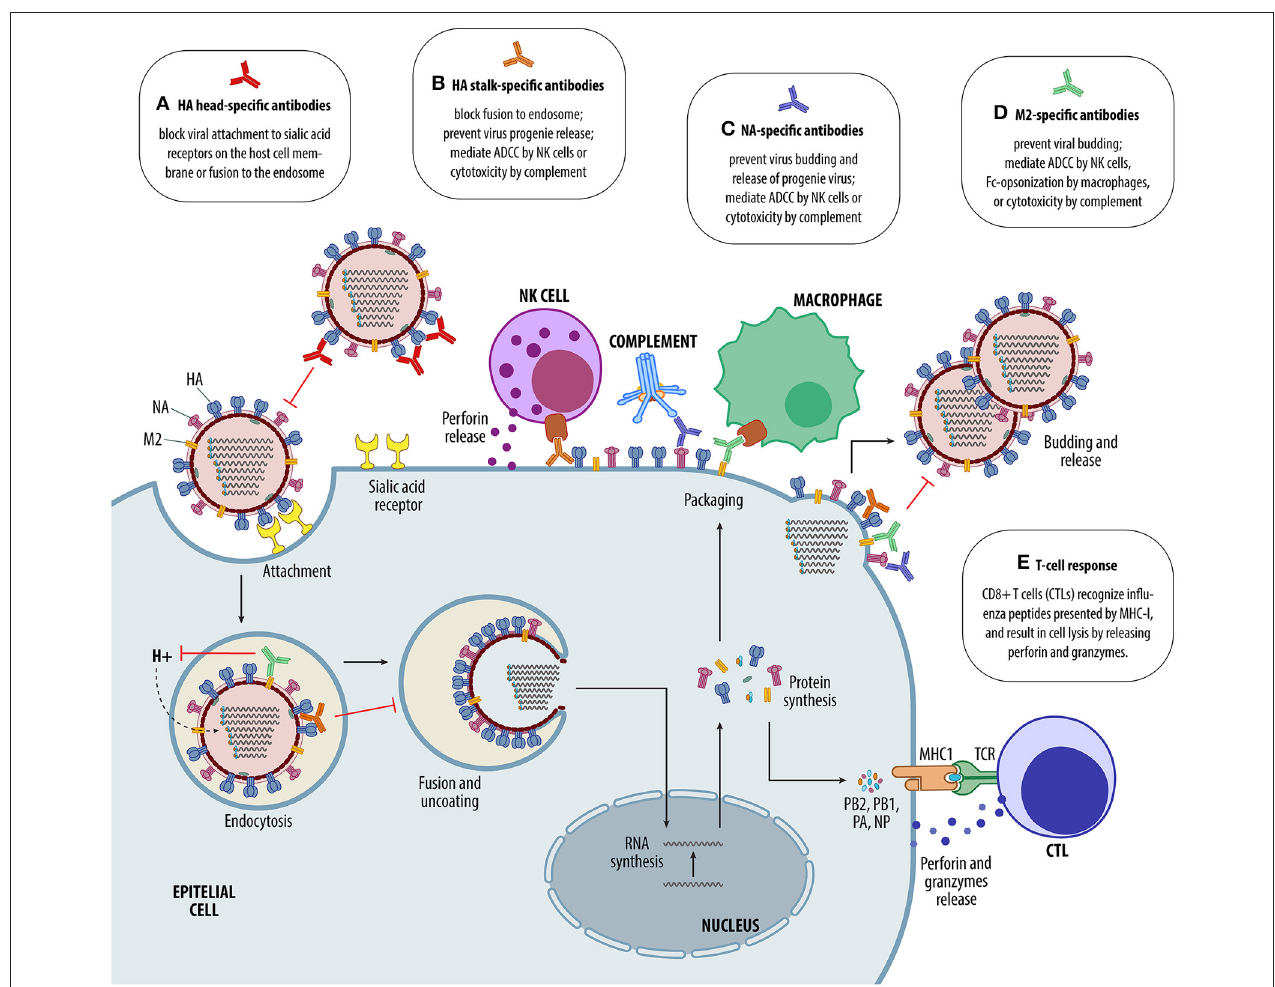
FIGURE 2 | Immune response elicited by different influenza vaccines. (A) HA-head-specific antibodies interfere or block virus binding to the sialic acid receptors on the cell surface and prevent virus entry to host cells. (B) HA-stalk-specific antibodies prevent virus fusion to the endosome, inhibit budding and release of new virus particles, and mediate antibody dependent cell-mediated cytotoxicity (ADCC) by natural killer (NK) cells or complement activation. (C) NA-specific antibodies inhibit budding and release of new virus particles, and mediate ADCC by NK cells or complement activation. (D) M2e-specific antibodies inhibit budding and release of new virus particles, and mediate ADCC by NK cells, Fc-opsonization by macrophages or complement activation. (E) CD8 + T cells (cytotoxic T lymphocytes, or CTLs) recognize influenza peptides presented by major histocompatibility complex class I (MHC-I) at the surface of infected cells via their T cell receptor (TCR), release cytotoxic granules containing perforin and granzymes, resulting in lysis of infected